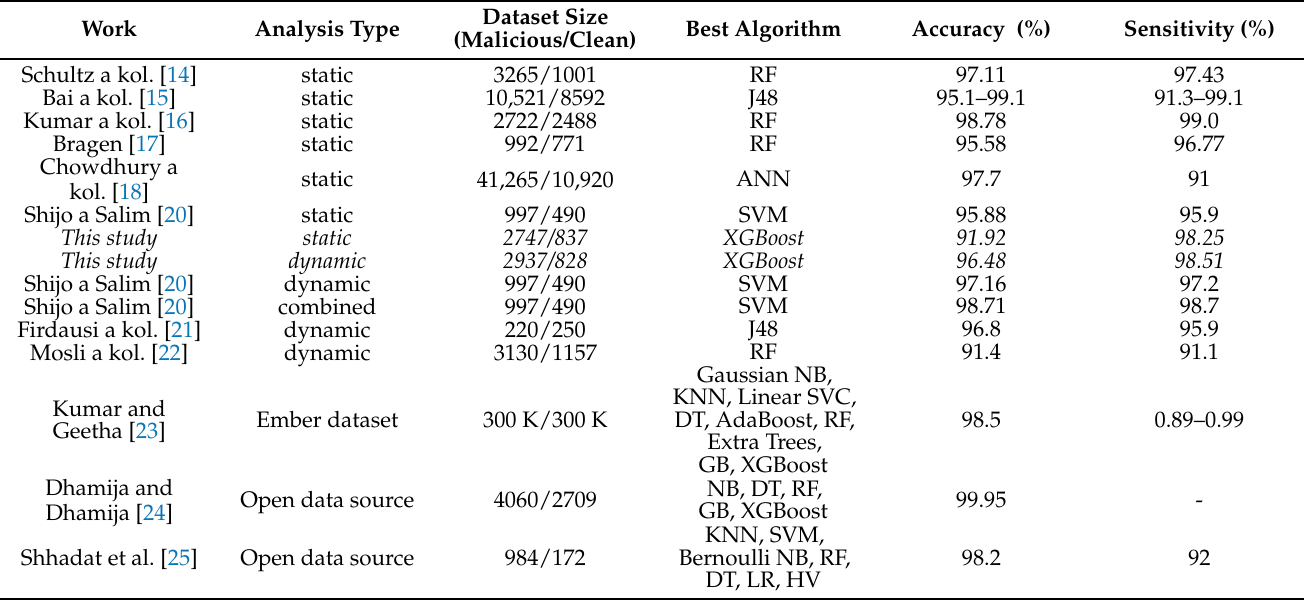
Table 15. Comparison with existing